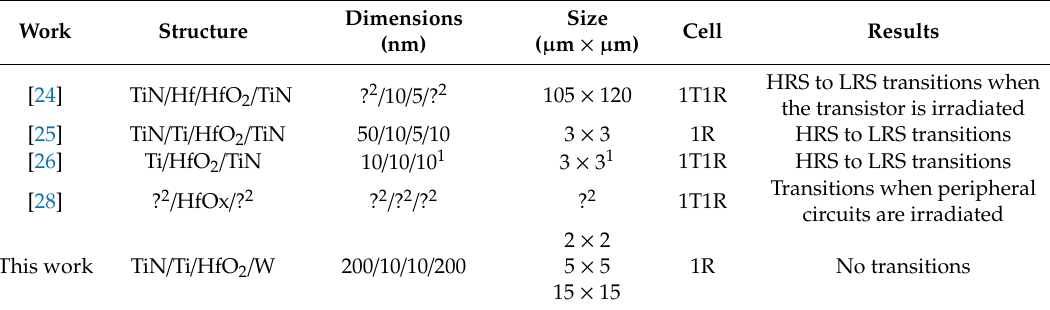
Table 1. Comparison of RRAM devices irradiated by a laser